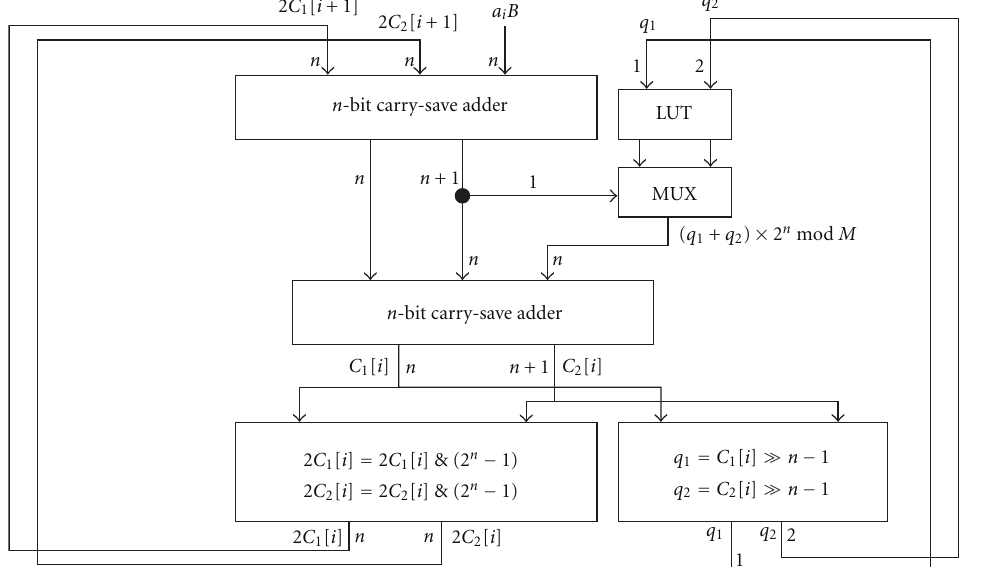
Figure 2: Modified sum of residues modular multiplier architecture.